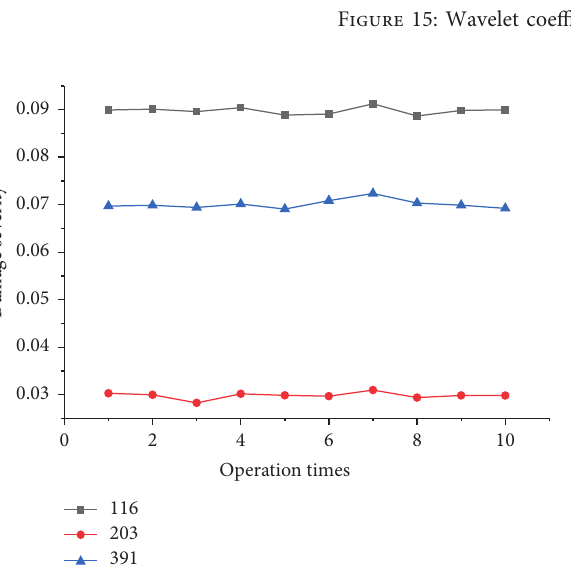
Figure 18: Damage severity identification of GA.